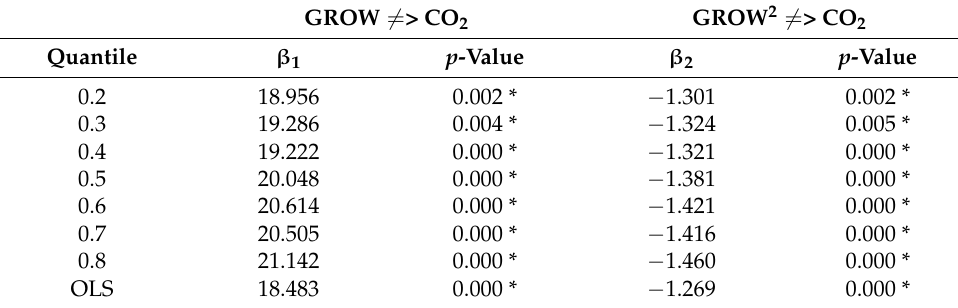
Table 4. The quantile results from GROW and GROW 2 to CO 2 . GROW (cid:54) = > CO 2 GROW 2 (cid:54) = > CO 2 Quantile β